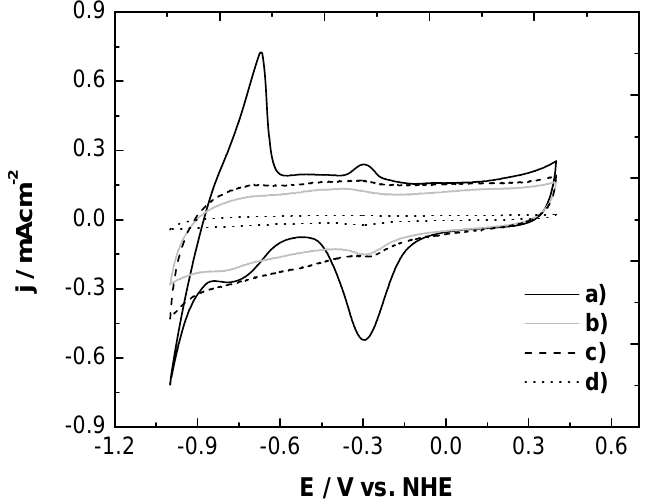
Figure 4. Cyclic voltammograms of ( a ) commercial Pd/C; ( b ) NR/C; ( c ) NB/C; and ( d ) NP/C catalysts in 1 M KOH at room